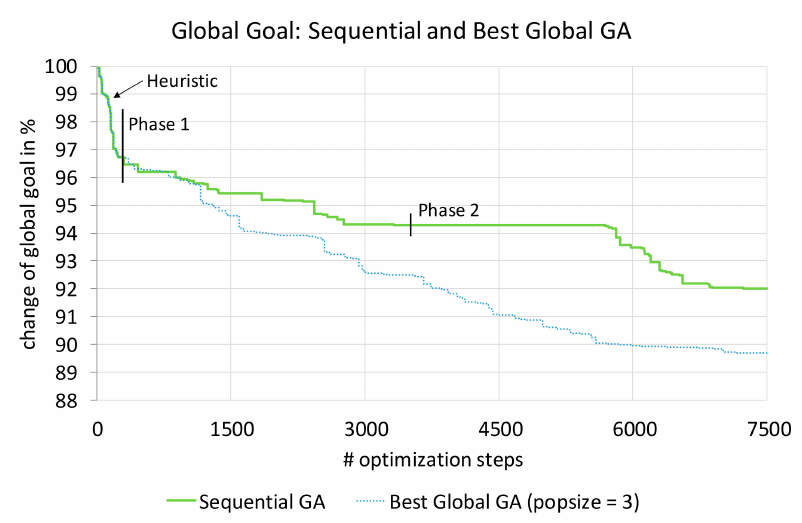
Figure 10. Sequential GA and best global